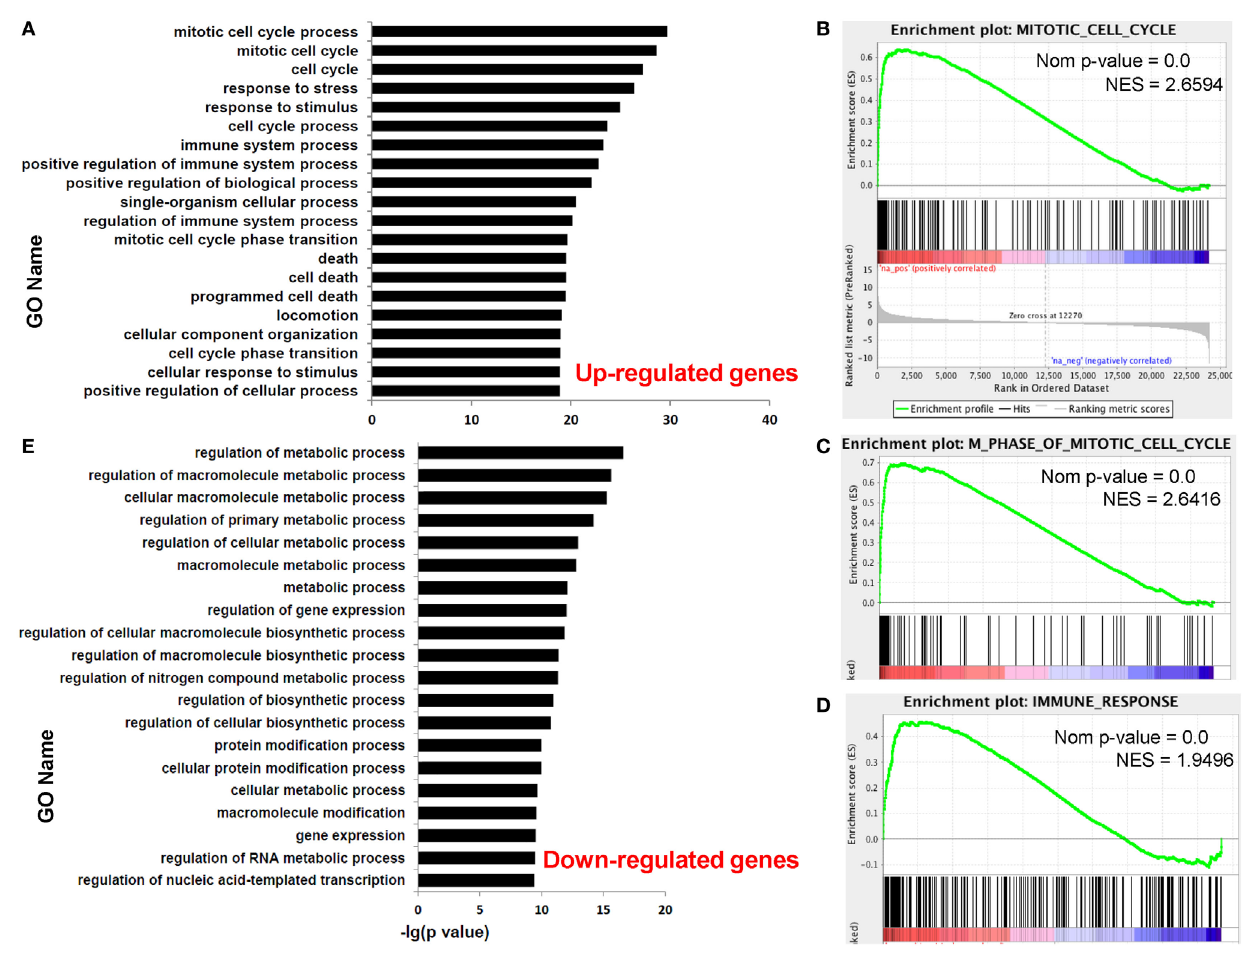
FigUre 2 | Human dCD8 T cells upregulate the genes involved in M phase of mitotic cell cycle and immune system process but downregulate those related to metabolic process. (a) The top 20 GO terms (biological process) enriched for the upregulated genes in human dCD8 versus pCD8 T cells. (B–D) GSEA plots of gene sets in GO categories including mitotic cell cycle (B) , M phase of mitotic cell cycle (c) , and immune response (D) in human dCD8 versus pCD8 T cells. (e) The top 20 GO terms enriched for the downregulated genes in human dCD8 T cells. The NES reflects the degree to which a gene set is upregulated (positive NES) in human dCD8 T cells and the corresponding nom P -value is indicated. Abbreviations: GO, gene ontology; dCD8 T, decidual CD8 + T; pCD8 T, peripheral blood CD8 + T; GSEA, gene set enrichment analysis; Nom, nominal; NES, normalized enrichment